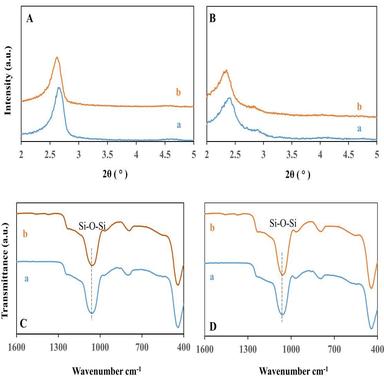
(A&B) XRD of the spent catalysts and (C&D) FT-IR of the spent catalysts. (A) MCM-41-S-Zn, (B) MCM-48-S-Zn, (C) MCM-41-S-Zn and (D) MCM-48-S-Zn, (a) Fresh catalyst, (b) spent catalyst.